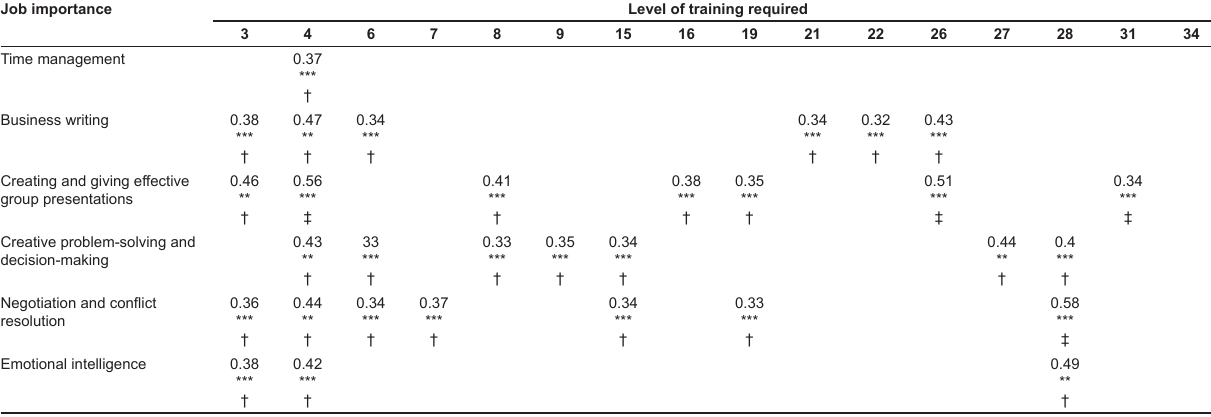
TABLE 6 Pearson product-moment correlations: Competencies relating to personal